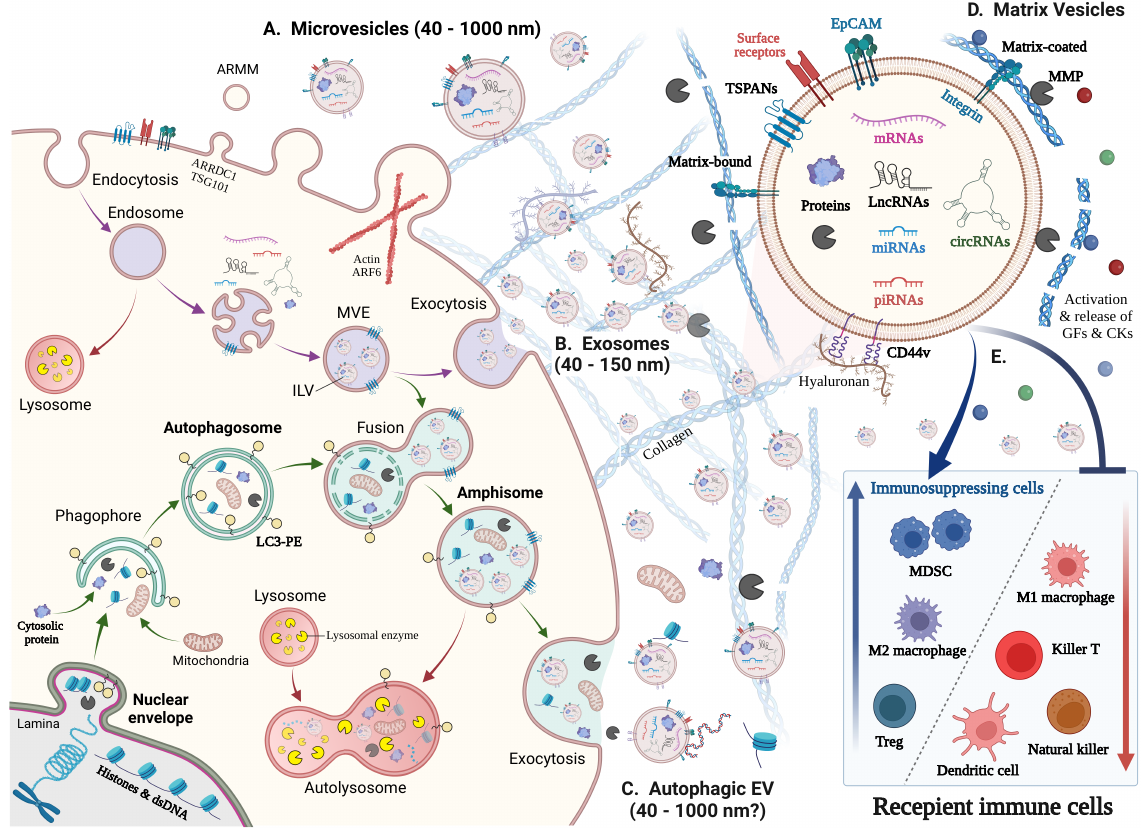
Figure 1. Biogenesis of various EV types and their immunoregulatory roles. (Left) Biogenesis of various EV types. ( A ) Microvesicles (40–1000 nm) arise from the outward budding and shedding of the plasma membrane. Small microvesicles called ARMM were recently discovered. ( B ) Exosomes (40–150 nm) are secreted via exocytosis of intraluminal vesicles (ILVs) by plasma membrane fusion with multivesicular endosomes (MVE) with the plasma membrane (purple arrow). ( C )